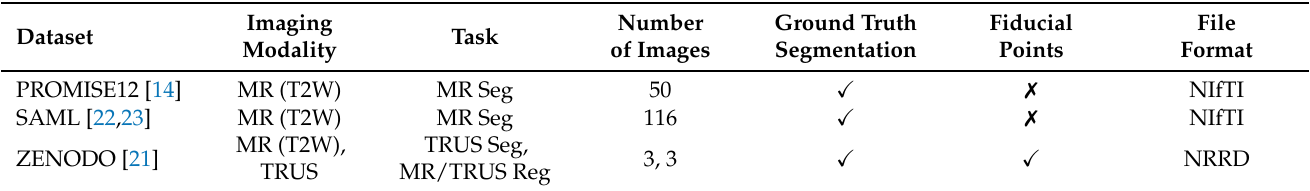
Table 1. Datasets description. As imaging modalities, only ZENODO contains TRUS images, even in a very limited quantity, being only 3. Fiducial points are also present only in the last dataset. Seg—segmentation; Reg—registration.